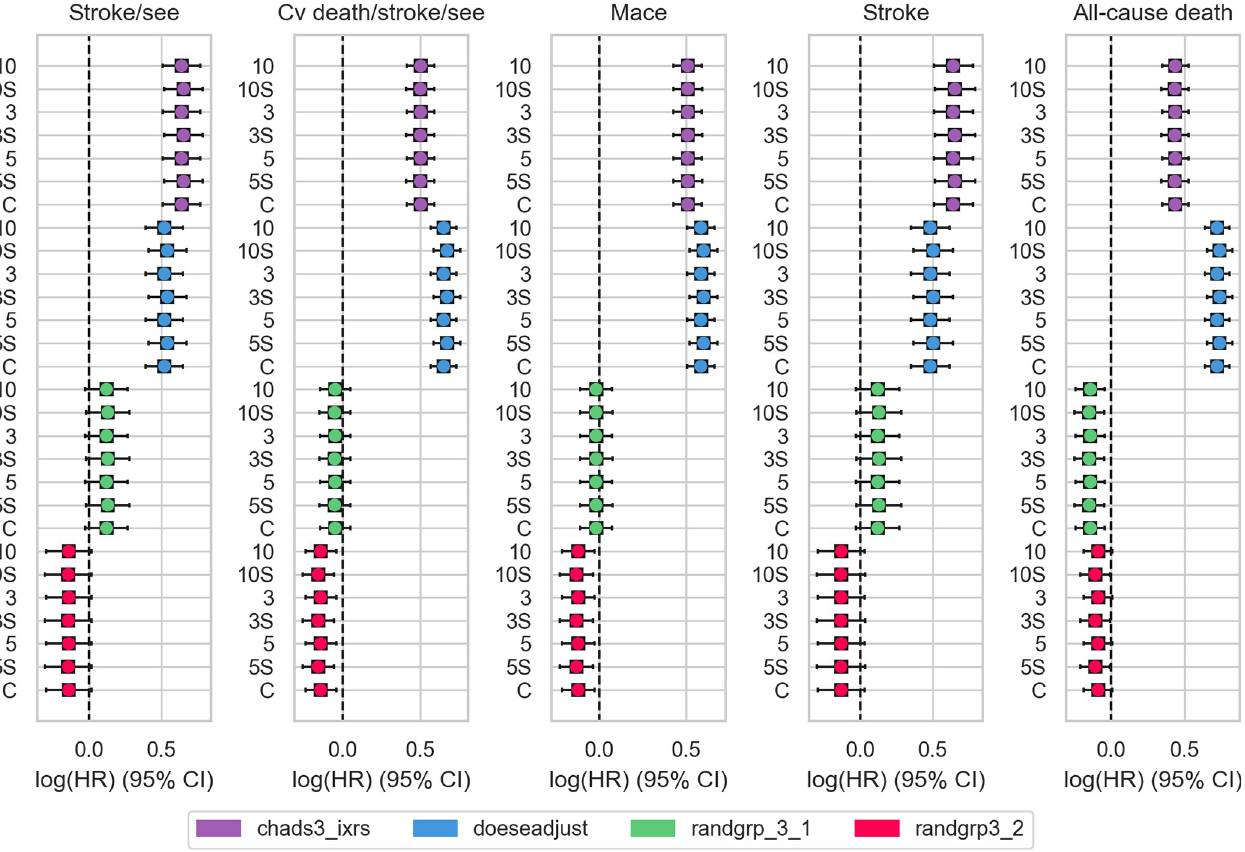
Fig 5. Federated time-to-event analysis of the ENGAGE-TIMI 48 study. Reproducing the ENGAGE-TIMI 48 study using 3, 5, and 10 clients (number) of both federated-only and hybrid approaches (number + S) compared with the results of the central analysis (C). The different covariates (colors) were regressed against five outcome variables (each subplot). The results of all five outcome variables and covariates are highly similar to the central analysis performed using the lifelines package.